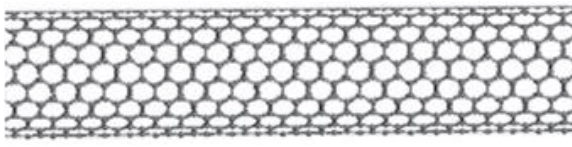
Figure 4. The structural model of carbon nanotube (CNT). (reprinted from Ref. [52] with permission from Elsevier).